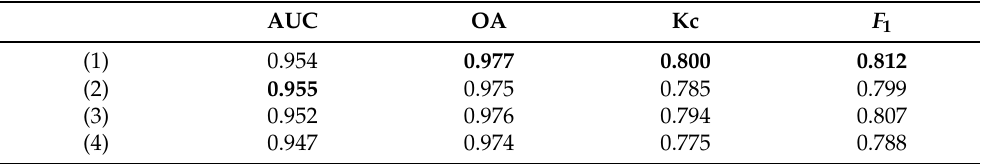
Table 9. Ablation study on the Sardinia dataset.